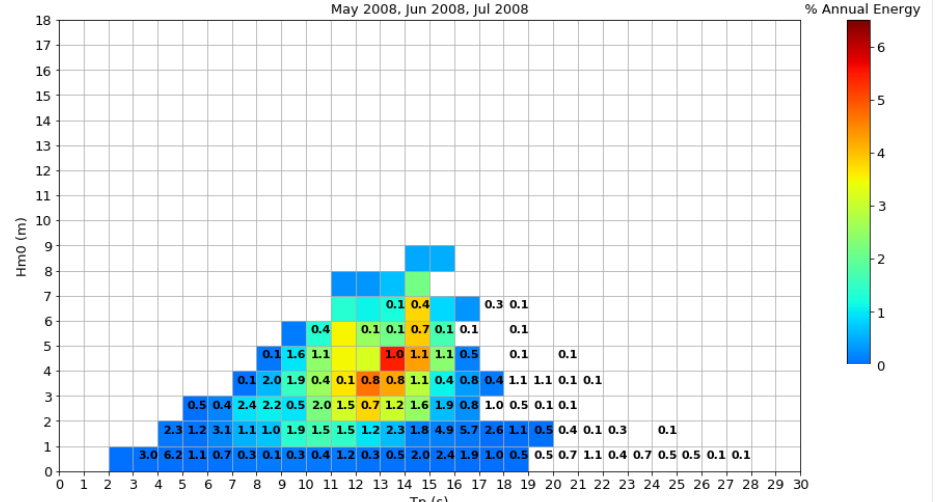
Fig 7. Scaled up Melvaig Peninsula ( H m0 , T p ) % occurrence scatter table (tabulated numbers) for May-Jul 2008 overlaid on Billia Croo ( H m0 , T p ) % annual incident energy scatter colour map for